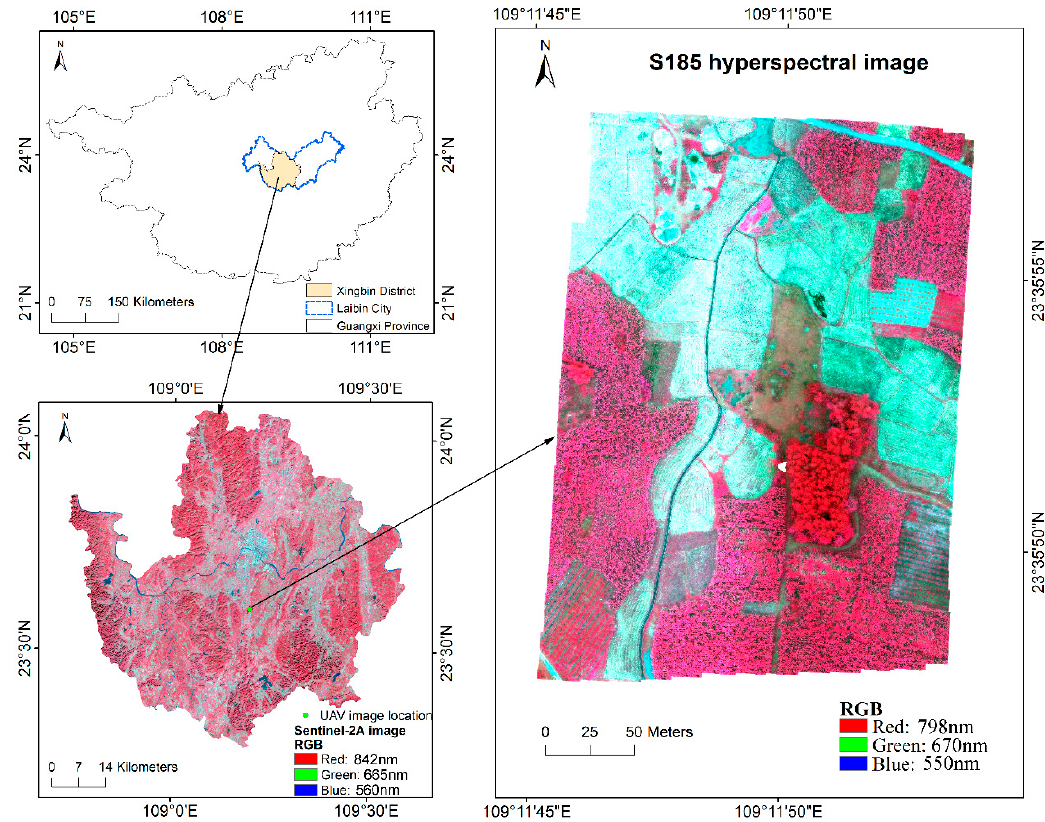
Figure 1. Geographic location and UAV image of the study area.